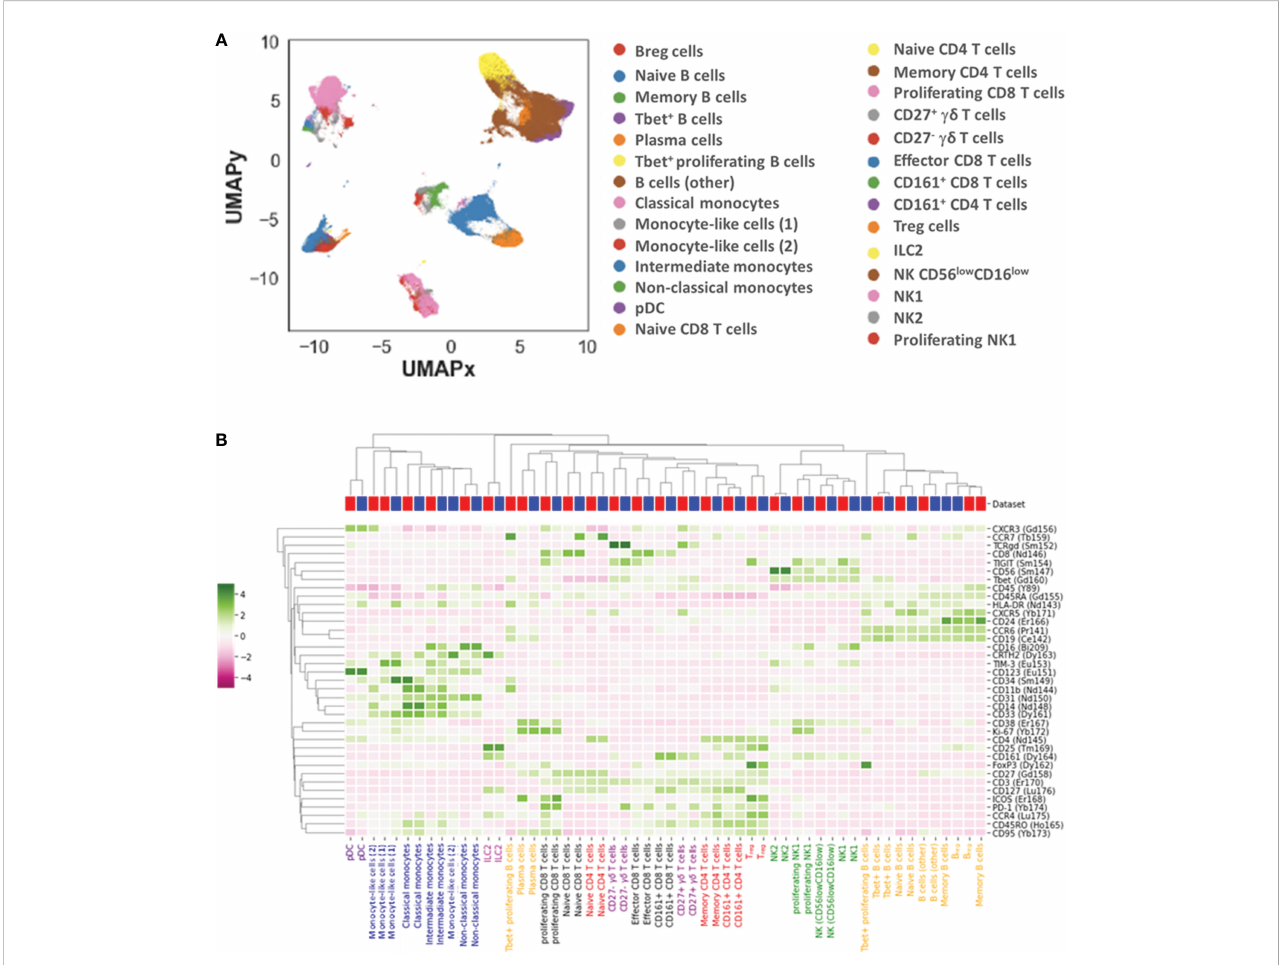
FIGURE 2 Landscape of immune cell subpopulations. Dimensionality reduction (UMAP) and annotation of subpopulations combining datasets 1 and 2 (A) . Heatmap illustrating immune cell subpopulation phenotypes in datasets 1 and 2 (B)